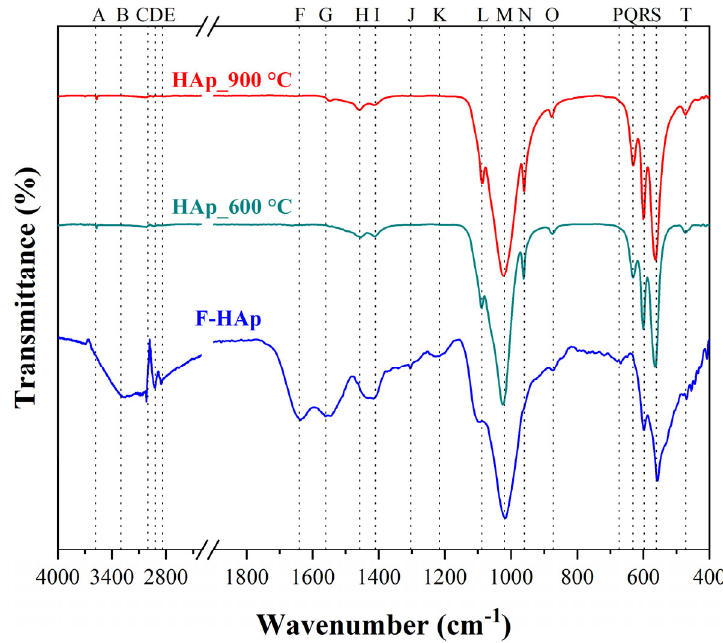
Figure 3. FT − IR Spectra for all HAp ‐ based materials. Table 3. FT − IR Spectroscopy for HAp ‐ based materials.